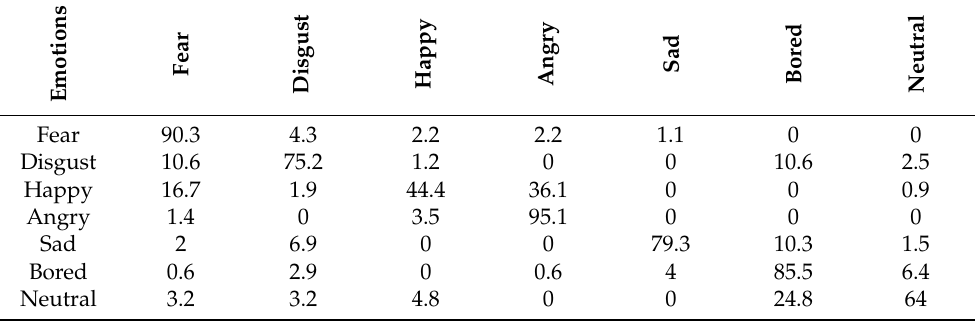
Table 4. Confusion matrix for 7 emotions, best settings, and berlin database